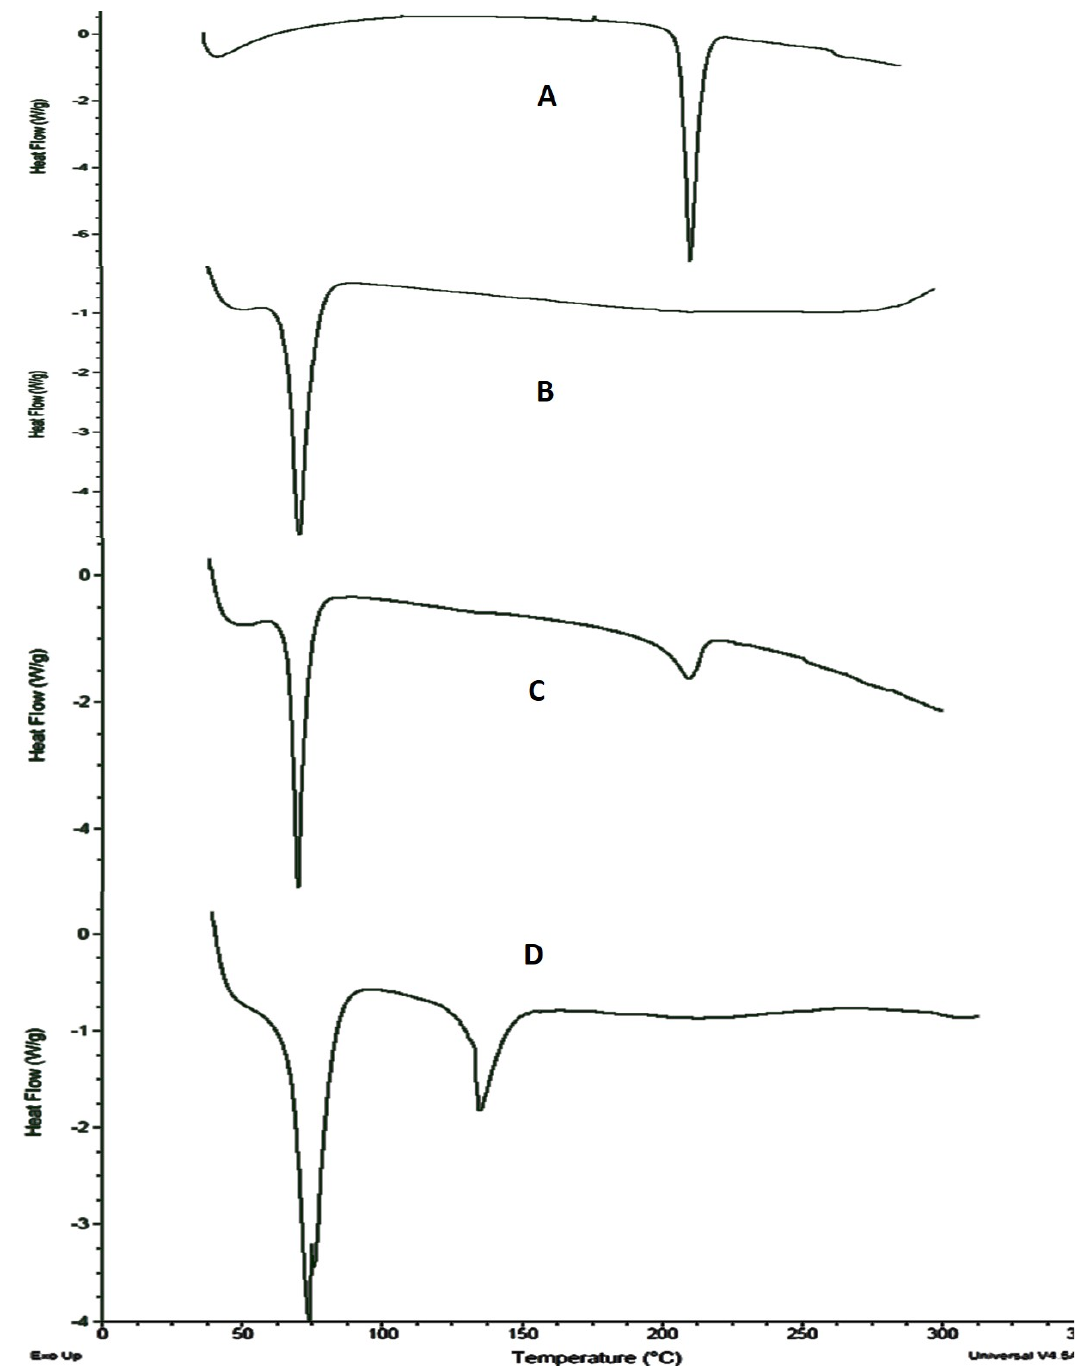
Figure 6. DSC thermogram of ( A ) alprazolam ( B ) compritol 888 ATO ( C ) physical mixture of alprazolam+ compritol 888 ATO ( D ) AF6.